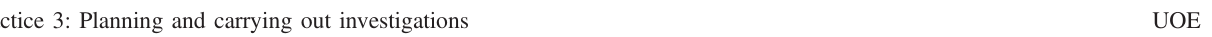
TABLE IV. Comparing the UOE with the learning goals found in the NGSS revealed that receiving and providing feedback was